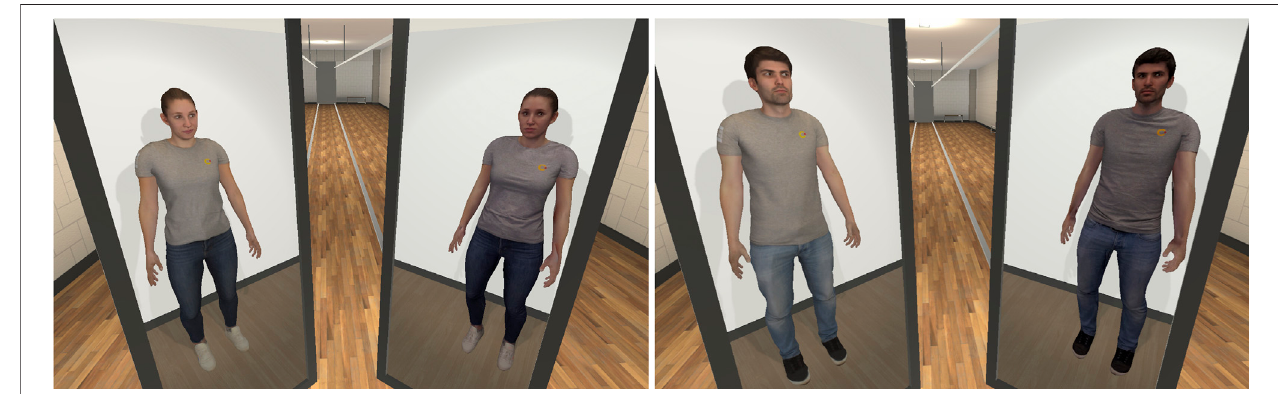
FIGURE 2 | The female (left) and male (right) virtual others. The left virtual monitor of each pair displays the high-cost version; the right virtual monitor displays the low-cost